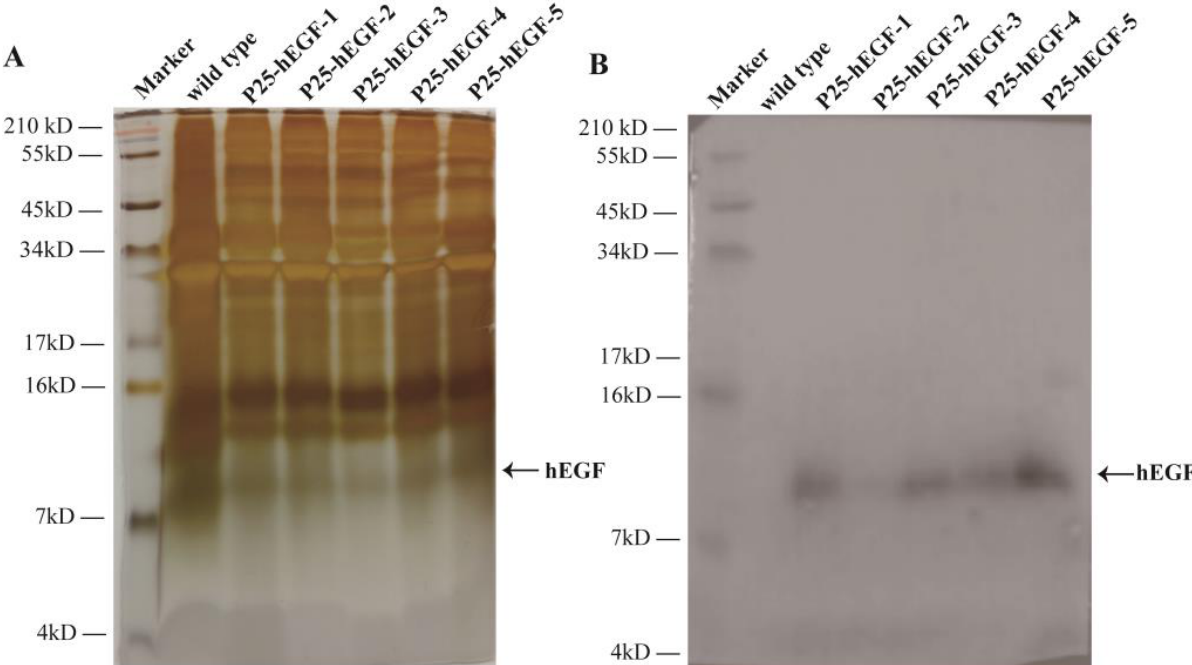
Figure 2. Expression analysis of the hEGF protein in transgenic cocoons. ( A ) SDS-PAGE analysis of the hEGF protein. Marker: protein marker and wild type: protein sample from wild-type cocoons. P25-hEGF-1, -2, -3, -4, and -5: protein samples from transgenic lineages P25-hEGF-1, -2, -3, -4, and -5, respectively. ( B ) Western blot analysis of hEGF protein by using an hEGF antibody.